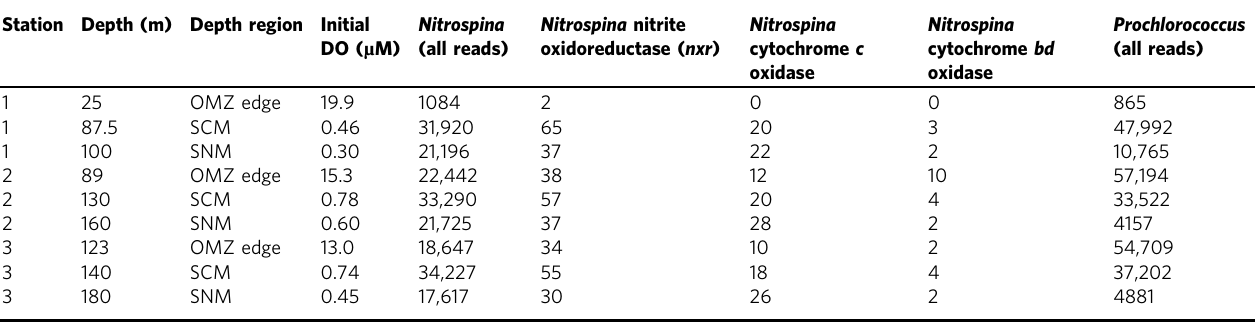
Table 2 Relative abundance of Nitrospina reads, functional genes from Nitrospina , and Prochlorococcus reads (all expressed per million reads) within metagenomes collected on the edge of the oxygen minimum zone (OMZ), in the secondary chlorophyll maximum (SCM), and in the secondary nitrite maximum (SNM) at Stations 1 – 3. Nitrospina Station Depth (m) Depth region Initial DO ( µ M) (all